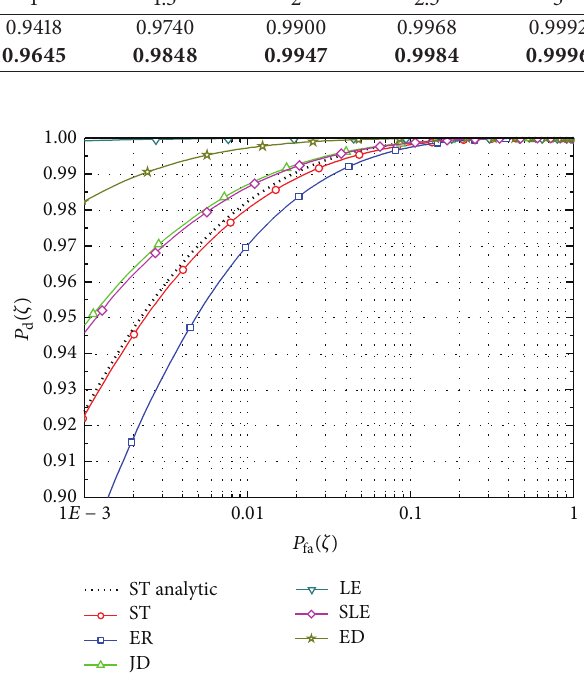
Figure 10: ROCs over an AWGN channel, for 𝐾 = 4, 𝑁 = 100, Figure 11: ROCs over an AWGN channel, for 𝐾 = 4, 𝑁 = 100, = 0 dB, SNR = − 1 dB, SNR = − 2 dB, SNR = − 8 dB, 𝑃 = 6, SNR = 0 dB, SNR = − 1dB, SNR = − 2dB, SNR = − 8dB, 𝑃 = 6, SNR 1 2 3 4 1 2 3 4 SNR 5 = − 10 dB, and SNR 6 = − 22 dB, with 𝜇 = 0 . 5 dB for the LE and SNR 5 = − 10 dB, and SNR 6 = − 22 dB, with 𝜇 = 0 . 5 dB for the LE the ED. Approximate reproduction of Figure 5(b) of [4]. and the ED. Same scenario of Figure 5(b) of [4], but with a different channel